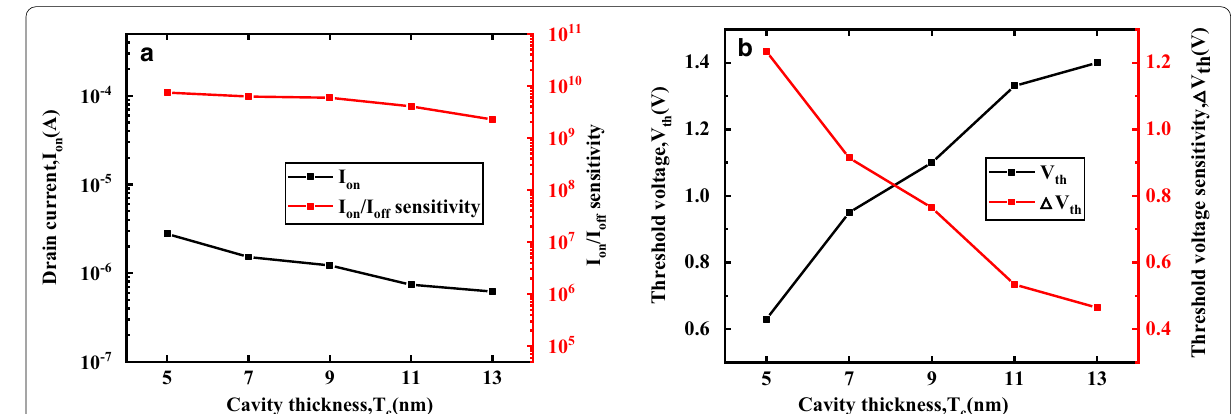
Fig.7 a Effect of different values of cavity thickness ( T c ) on I on , I on / I off sensitivity, b V th and △ V th of DM-DSTGTFET at V g